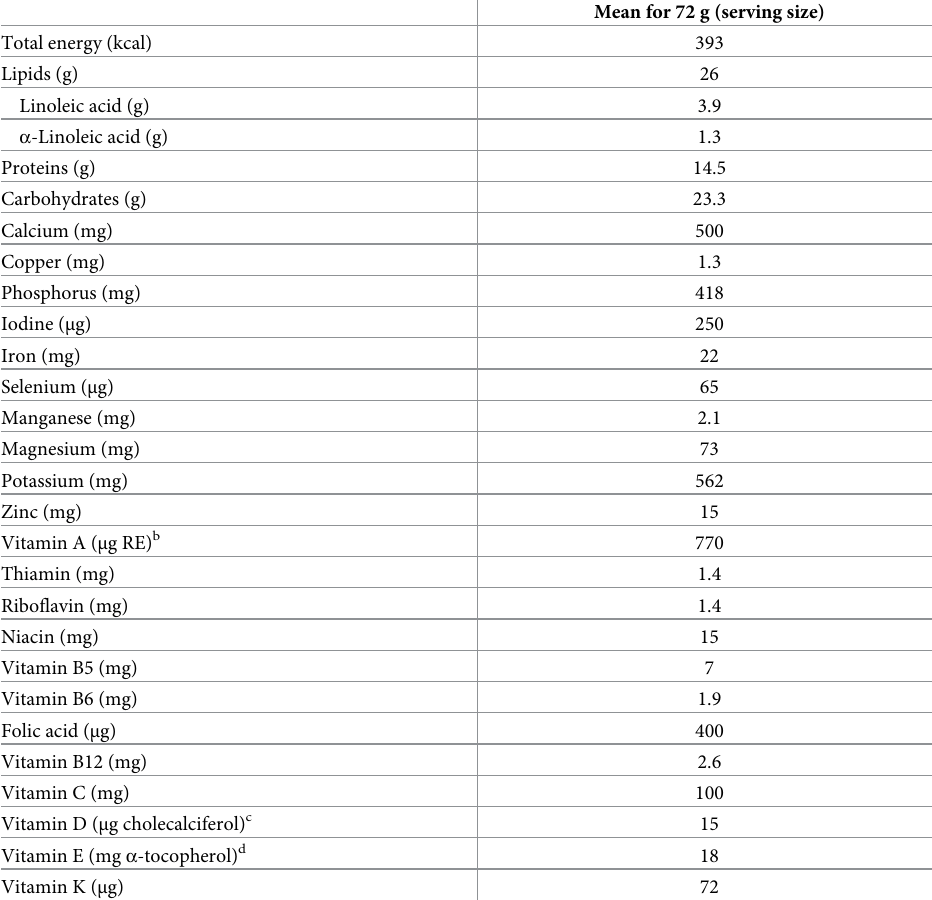
Table 1. Nutritional values of the BEP supplement for pregnant women a